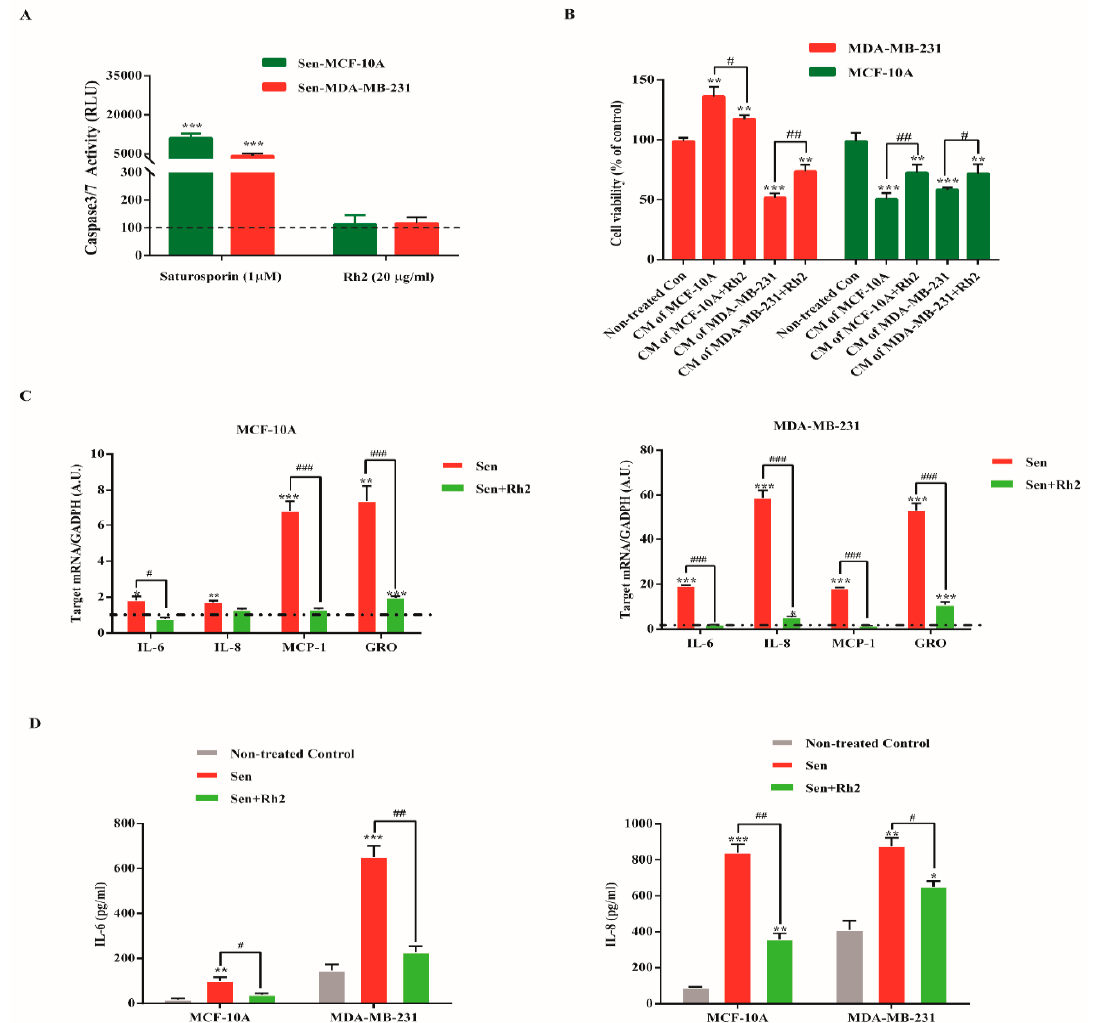
Figure 4. Rh2 suppressed paracrine effects of SASP in breast cell lines. ( A ) Senescent MDA-MB-231 and MCF-10A were exposed to Rh2 for 48 h, after which caspase 3/7 activity was quantified. The dotted line indicates fluorescence level in nontreated senescent cells. ( B ) MDA-MB-231 and MCF-10A cells were cultured with indicated CM for 24 h. The cell viability was assayed by WST-1 method. ( C ) Fold changes in mRNA levels of IL-8, IL-6, CXCL1, and MCP-1. The dotted line indicates expression level in control cells, set at 1 for each gene. N = 3. A.U., arbitrary units. ( D ) ELISA assay of IL-6 and IL-8. * indicates p < 0.05 versus Non-treated con. ** indicates p < 0.01 versus Non-treated con; *** indicates p < 0.001 versus Nontreated con. # indicates p < 0.05 versus CM group. ## indicates p < 0.01 versus CM group. ### indicates p < 0.001 versus CM alone group.